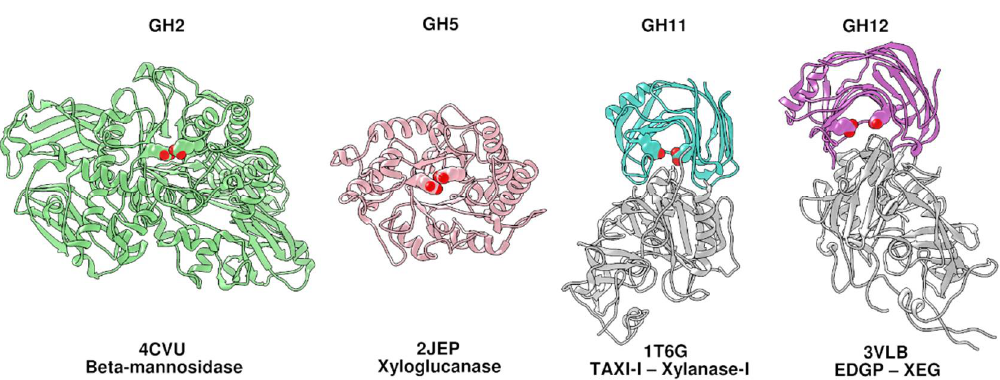
Figure 1. Structure comparison of representative members of GH families. For each structure, the PDB code and the enzyme names are reported below each model. GH11 and GH12 are reported with the respective inhibitors (gray) as they appear in PDB accessions. Catalytic amino acids are shown in spacefill representation.